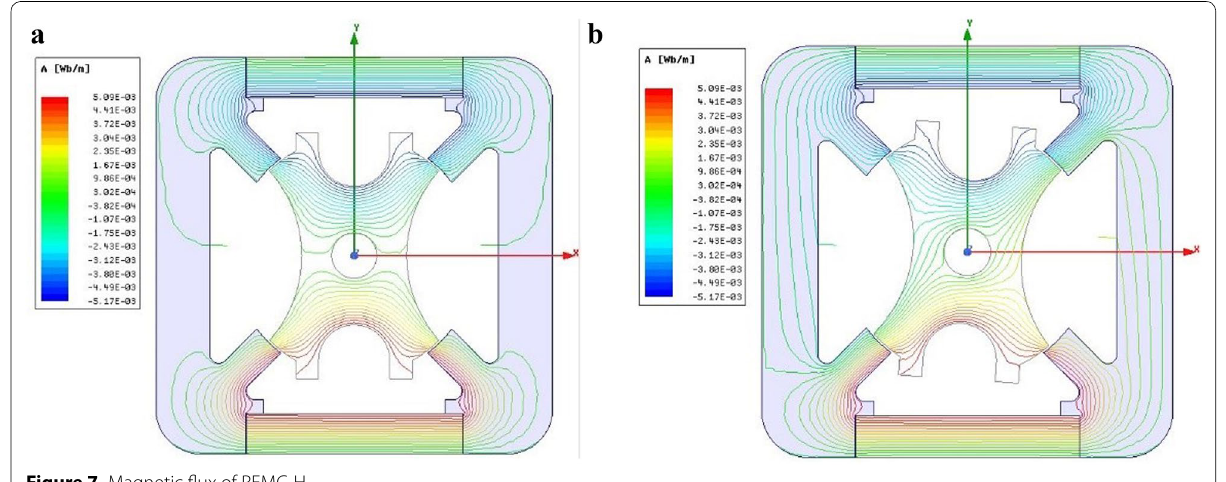
Figure 7 Magnetic flux of REMC-H